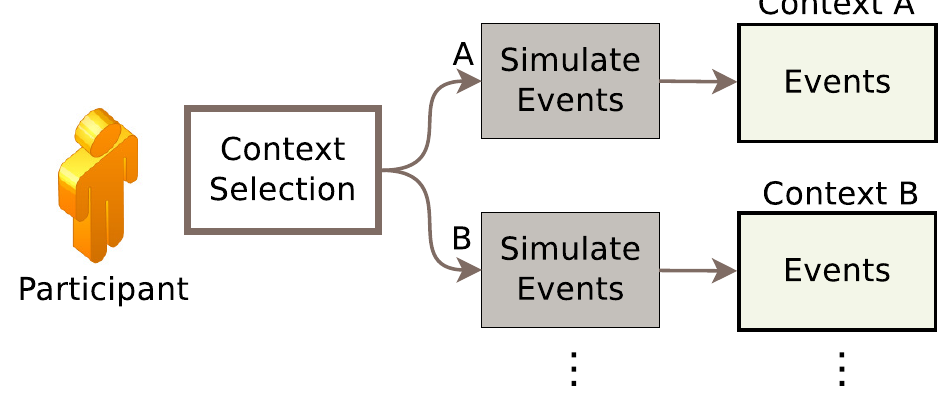
Figure 3. The simulation